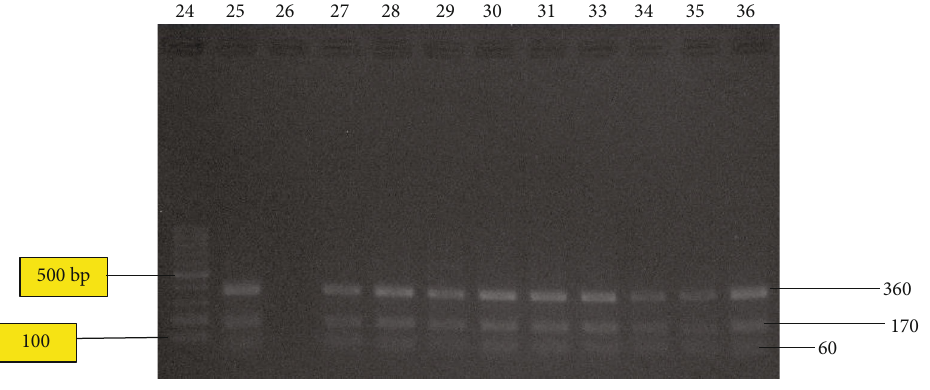
Figure 4: RFLP pattern of PCR product of liver fl uke collected from bovine in Shah Alam, Banting, Taiping, and Ipoh abattoirs after digestion with RsaI enzyme. Lane 24: 1000 bp ladder molecular; lane 25 positive control while; lane 26 is the negative control; lanes 27 to 36: denoted to those of F. gigantica . The PCR product digested were run on 2% agarose gel at 100 v for 60